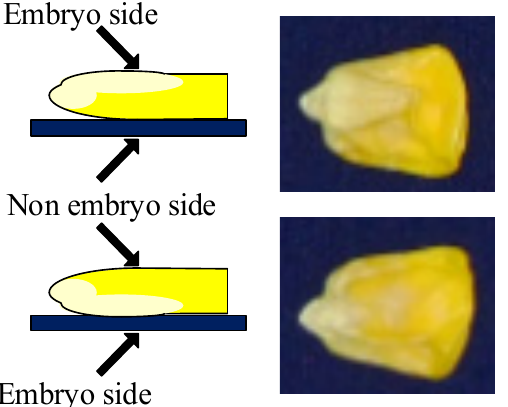
Figure 2. Position of sweet corn seeds in image acquisition.